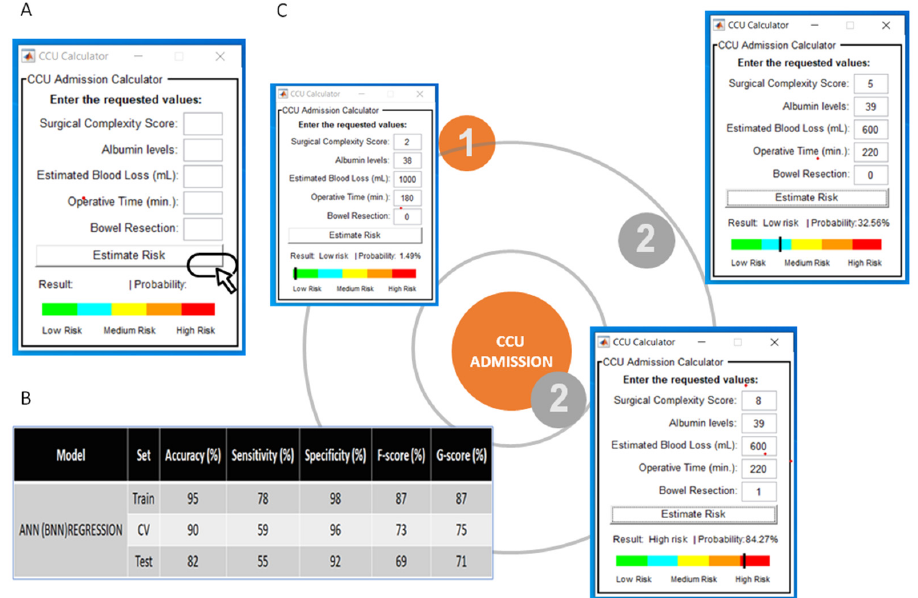
Figure 4. ( A ) Screenshot from the Critical Care Unit (CCU) calculator Graphical User Interface for the prediction of CCU admission. ( B ) Performance of the Artificial Neural Network (ANN(BPN)) algorithm used for the development of the Graphical User Interface based on the regression principles. ( C ) Examples of clinical application. Note that in the same patient, intra-operative decision making for rectosigmoid resection and stoma formation would massively increase the risk for CCU admission.